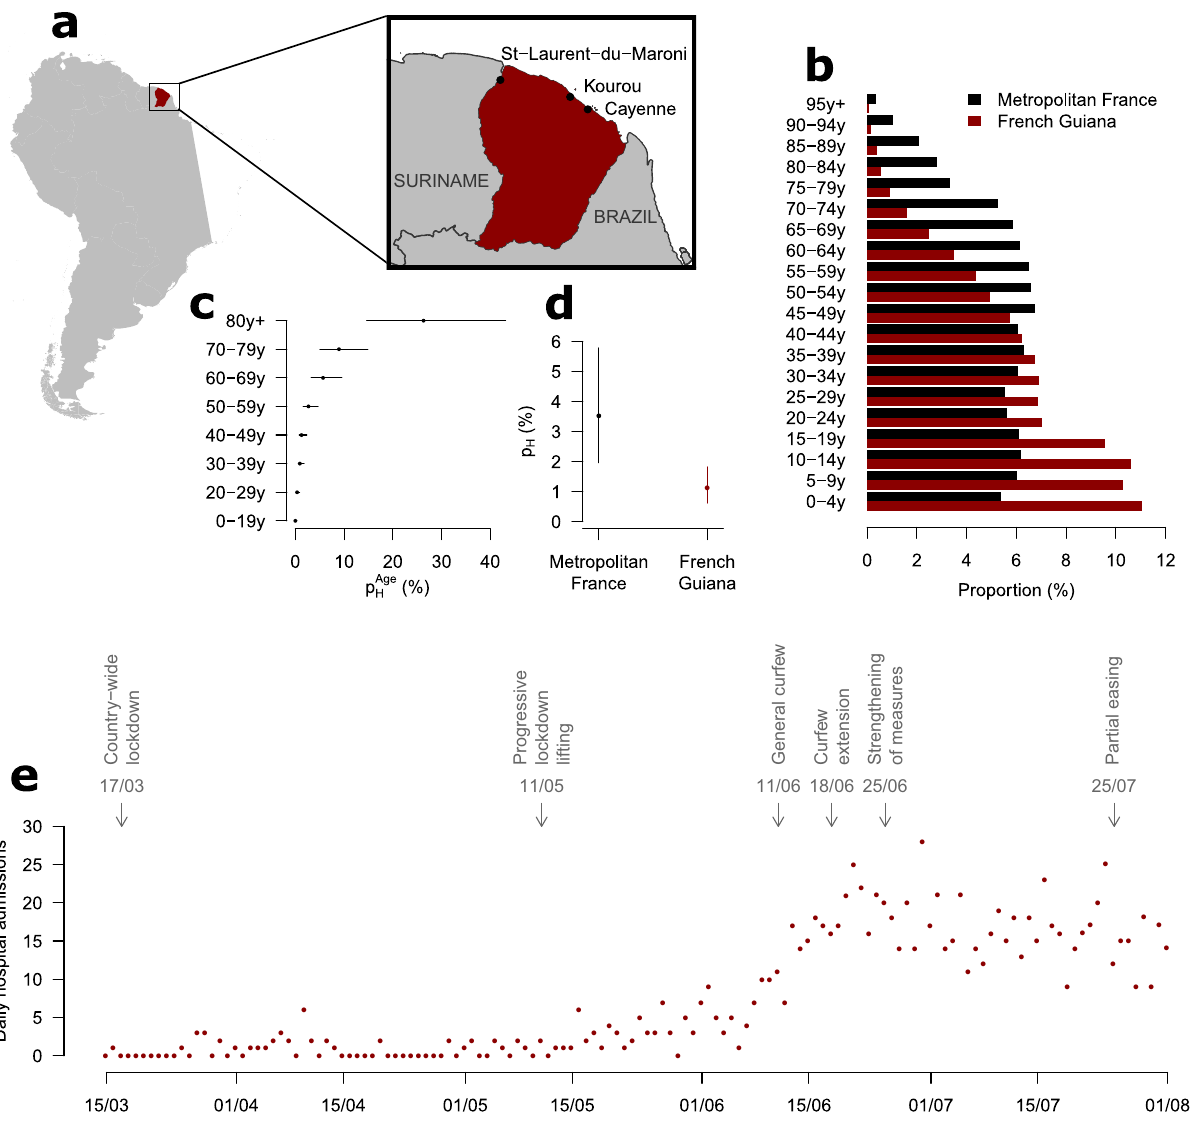
in Metropolitan France (%). d Average H